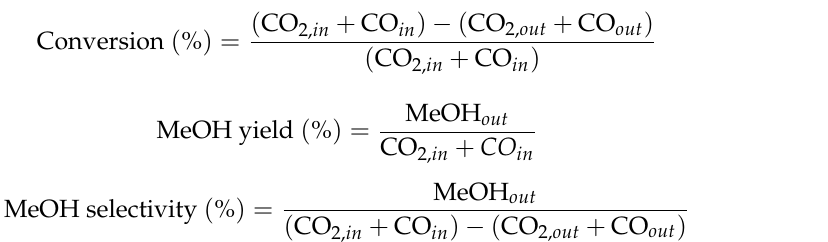
Table 2. Factors and values of their levels chosen in the factorial design of ANOVA analysis. Code Factor A CO concentration in the feed (mol %) 0 20 B Temperature ( ◦ C) 200 280 C Recycle (%) 0 90 D Water removal (%) 0